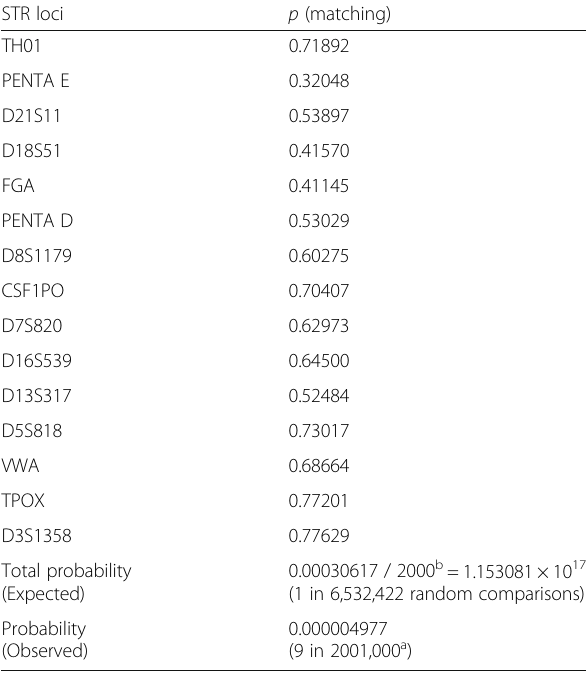
Table 3 Expected probability for sharing one/two allele(s) between two unrelated individuals for the Powerplex 16 kit in the state of Mexico database ( N =